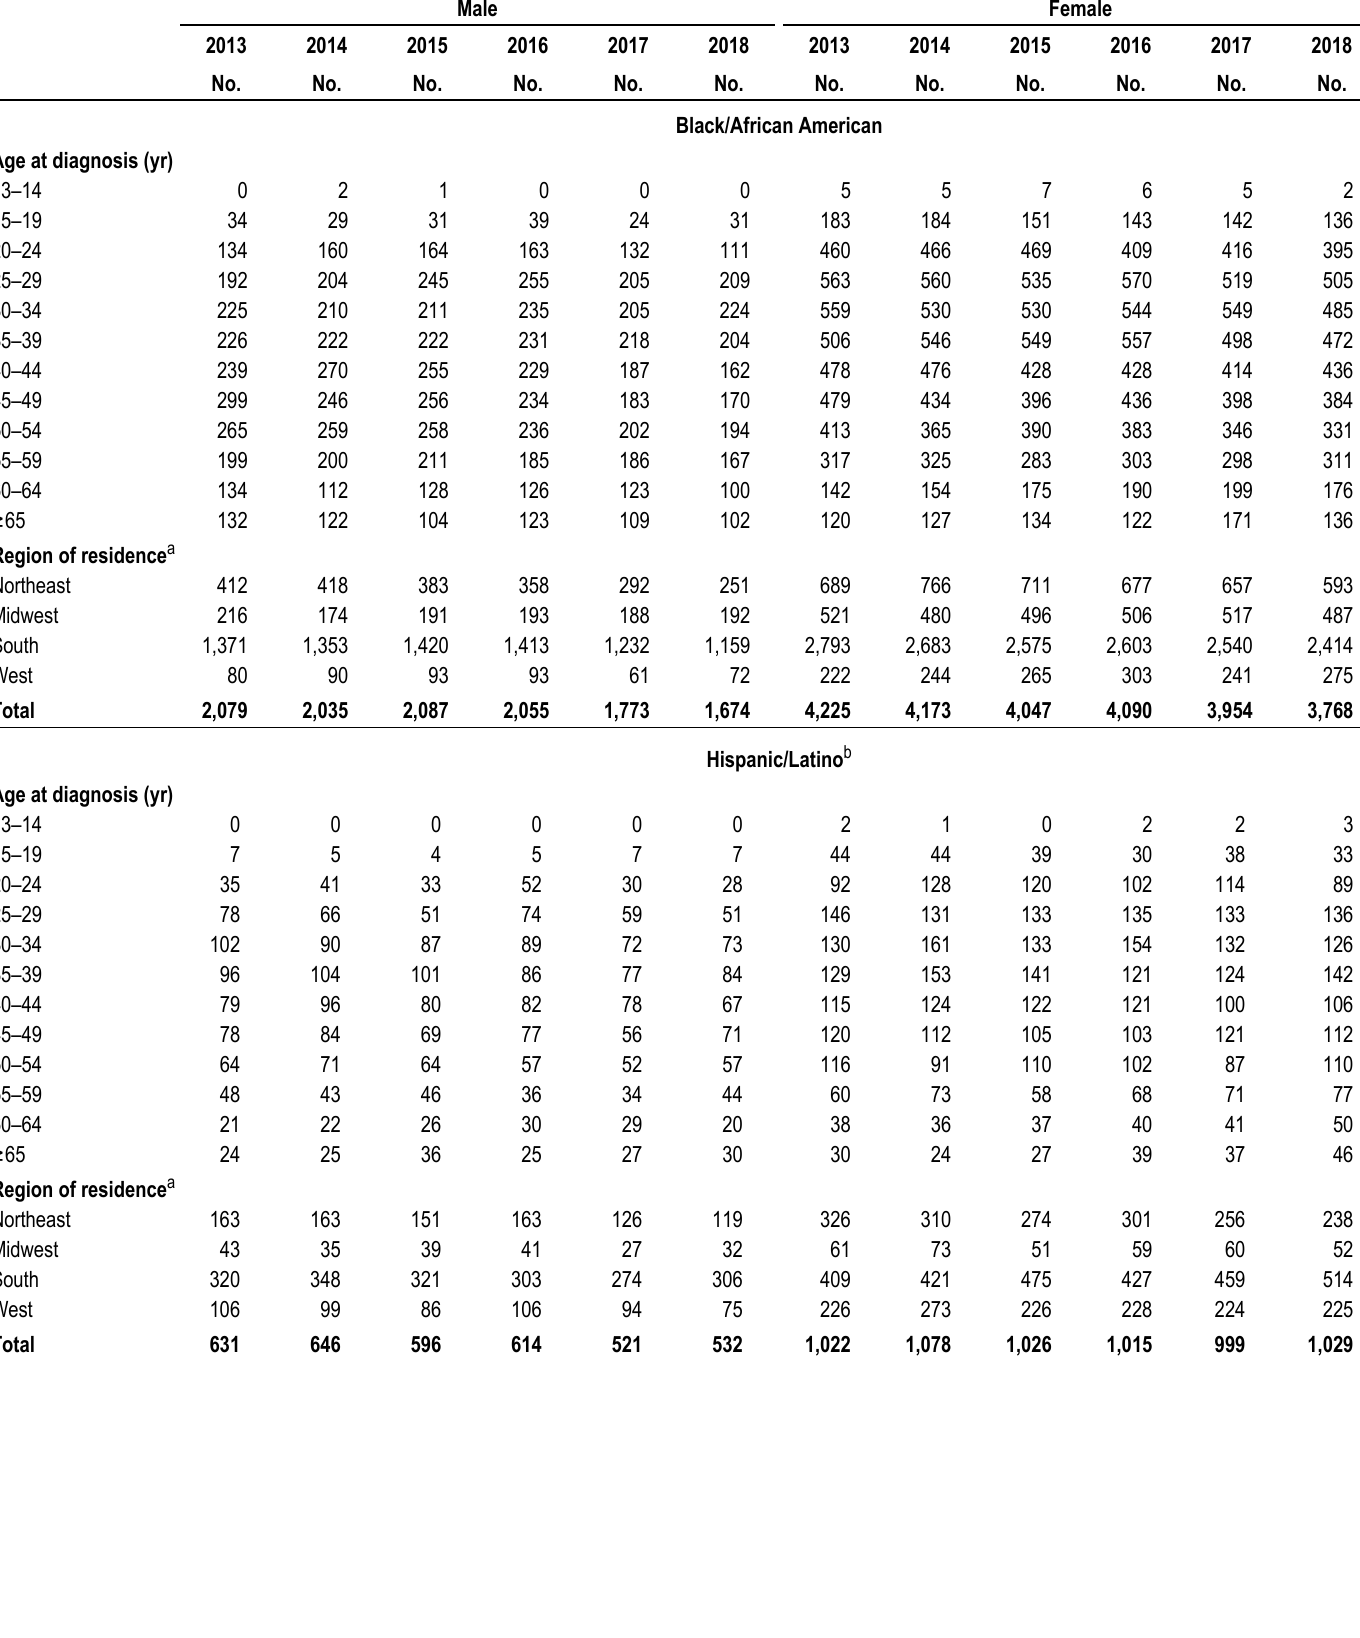
Table 9a. Diagnoses of HIV infection attributed to heterosexual contact, by selected characteristics, 2013–2018—United States (cont) Male